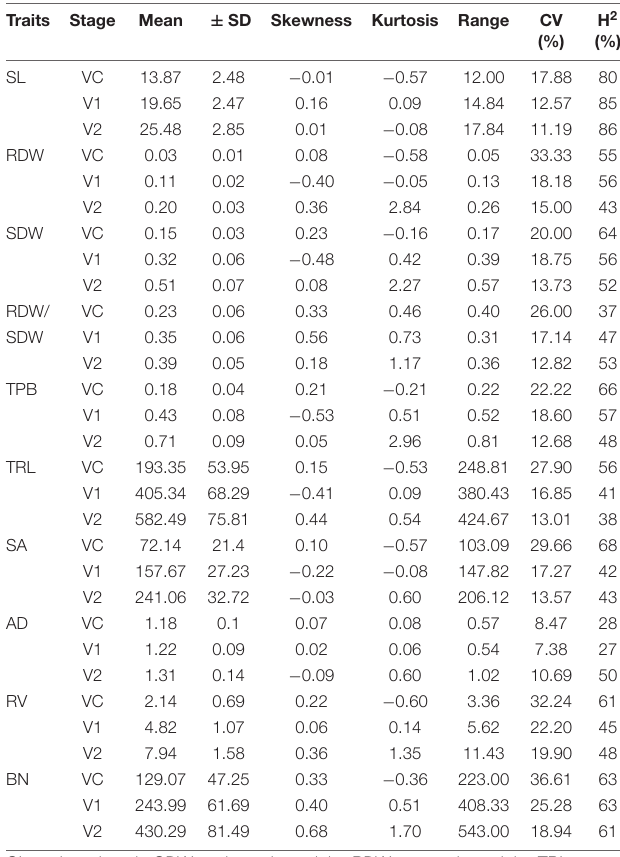
TABLE 2 | Descriptive statistical results of seedling root and shoot related traits at three